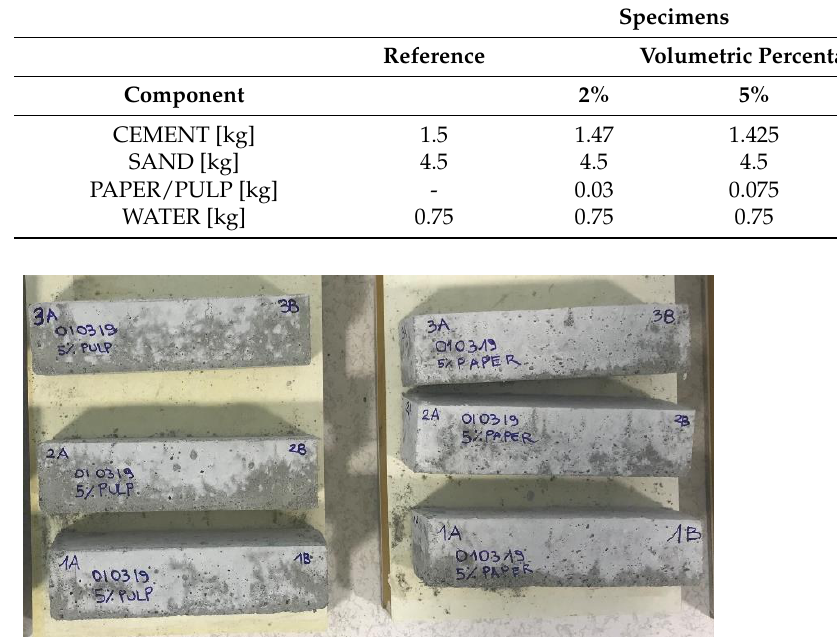
Figure 2. Some of the prepared specimens.